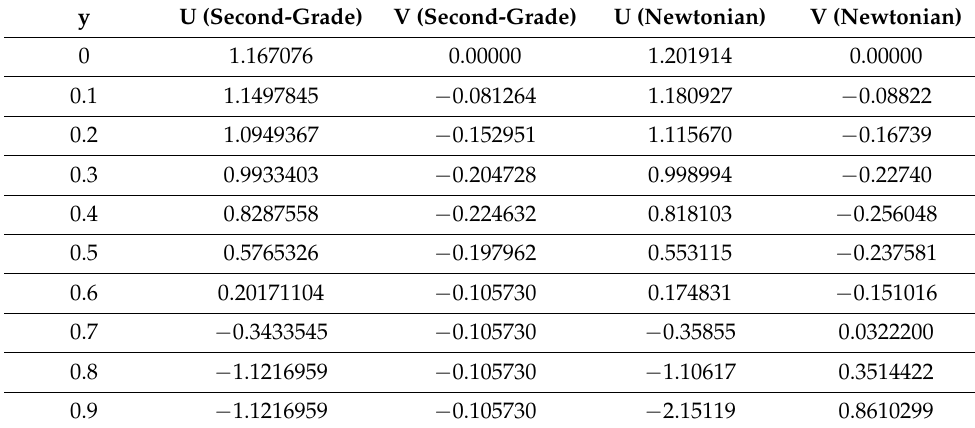
Table 1. Comparison of velocity distribution for a second-grade fluid when Re = 0.1 and for a Newtonian fluid obtained from Reference [25] for fixed values of M = 1, K = 0.1 α = 0.4, β = 0.4, ε = 0.1, Q =